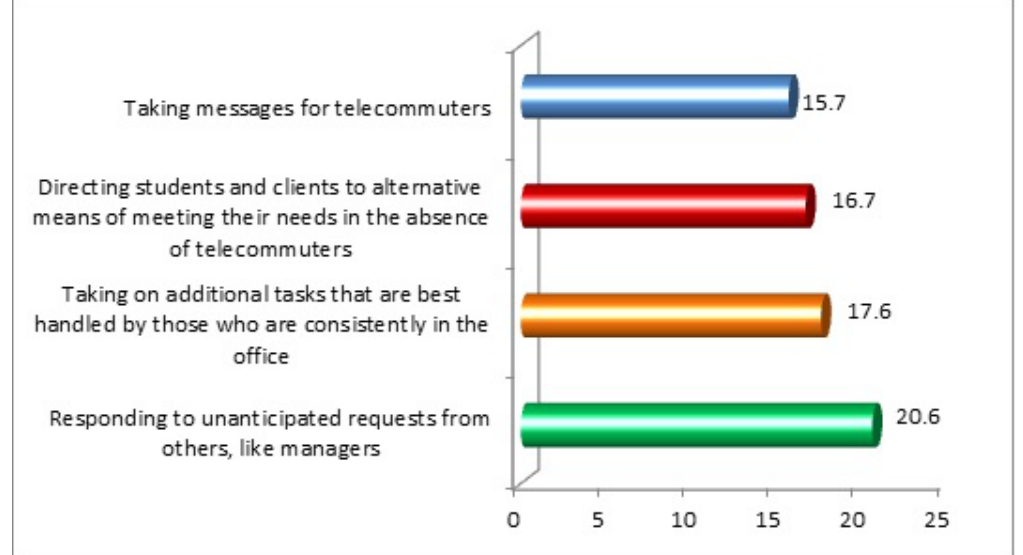
Figure 5 . Effect of co-workers’ telecommuting on office-based